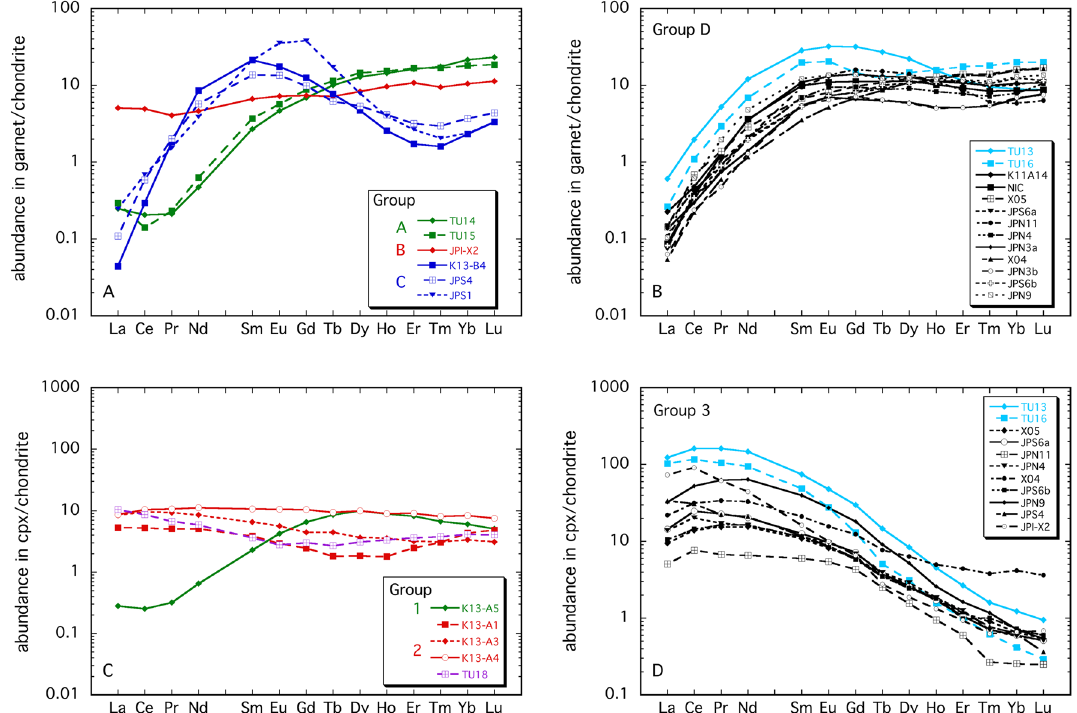
Figure 2. Chondrite-normalized REE patterns for garnet ( A , B ) and clinopyroxene ( C , D ) illustrating the different signatures as described in the text. Normalization is after McDonough and Sun 27 . The samples in blue in B – D are from Pelly Bay, the rest being from Somerset